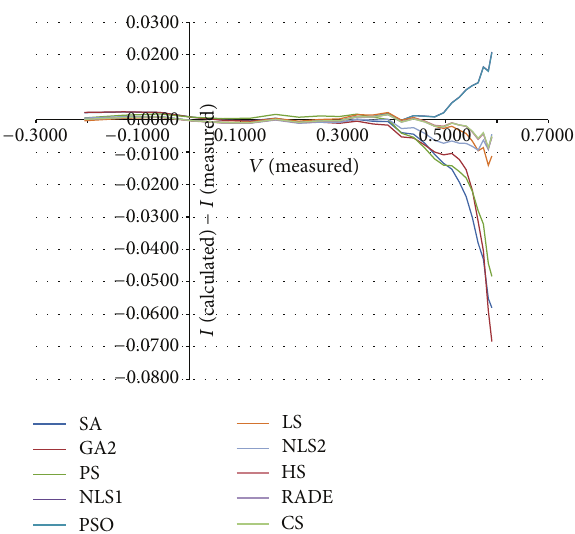
Figure 3: Errors between calculated and measured currents (single algorithm).